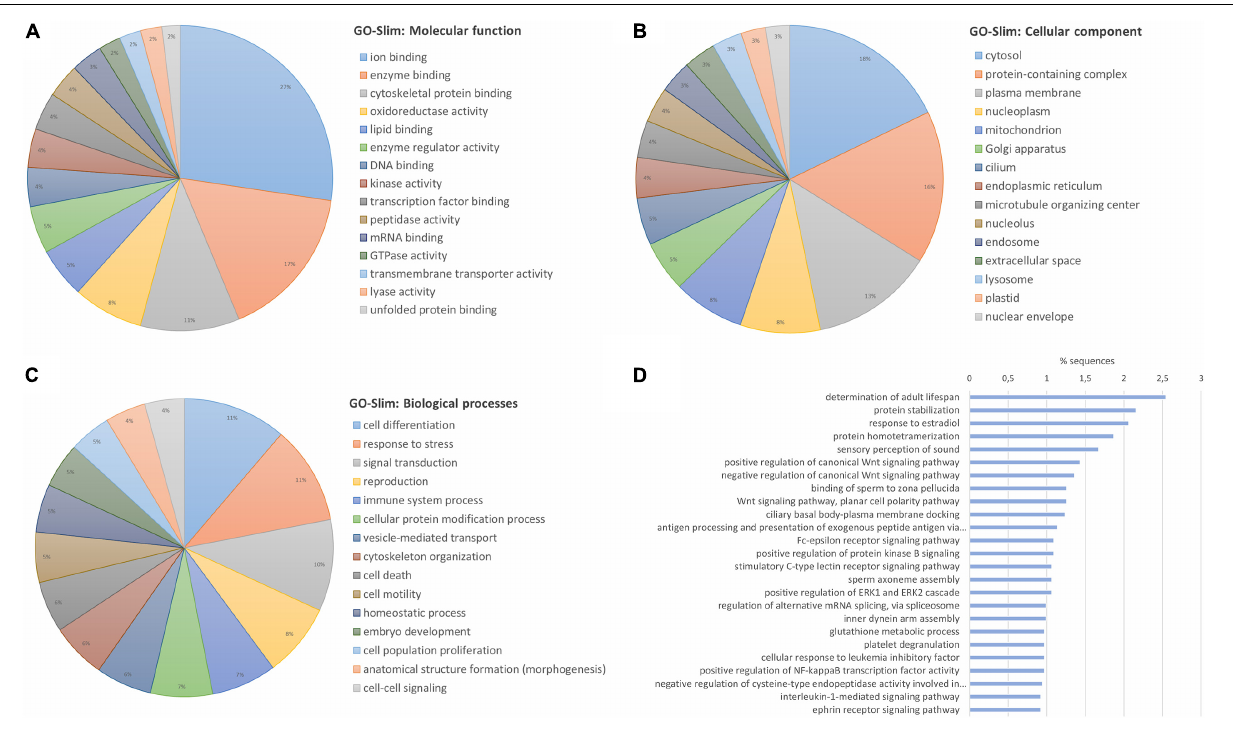
FIGURE 1 | General characterization of gill proteome from the marine mussel ( M. galloprovincialis ) based on the confidently identified proteins. Identified proteins in the proteomic analysis were submitted to an enrichment analysis with GO-Slim terms to obtain a generic view of the type of proteins that were identified in the gill proteome. The top 15 groups of GO-Slim terms with the highest number of representative proteins are shown for (A) “molecular function”; (B) “cellular component”; and (C) “biological processes.” (D) The most present specific biological processes are also represented without GO-Slim